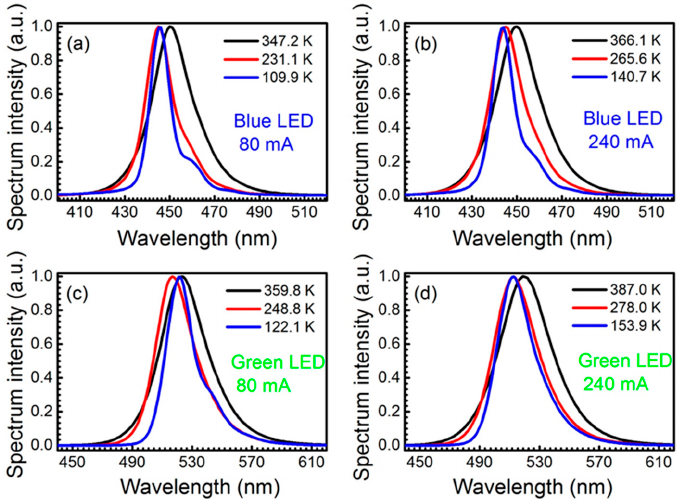
Figure 3. Normalized electroluminescence (EL) spectra at selected T j for the blue LED at ( a ) 80 mA and ( b ) 240 mA, and for the green LED at ( c ) 80 mA and ( d ) 240 mA.